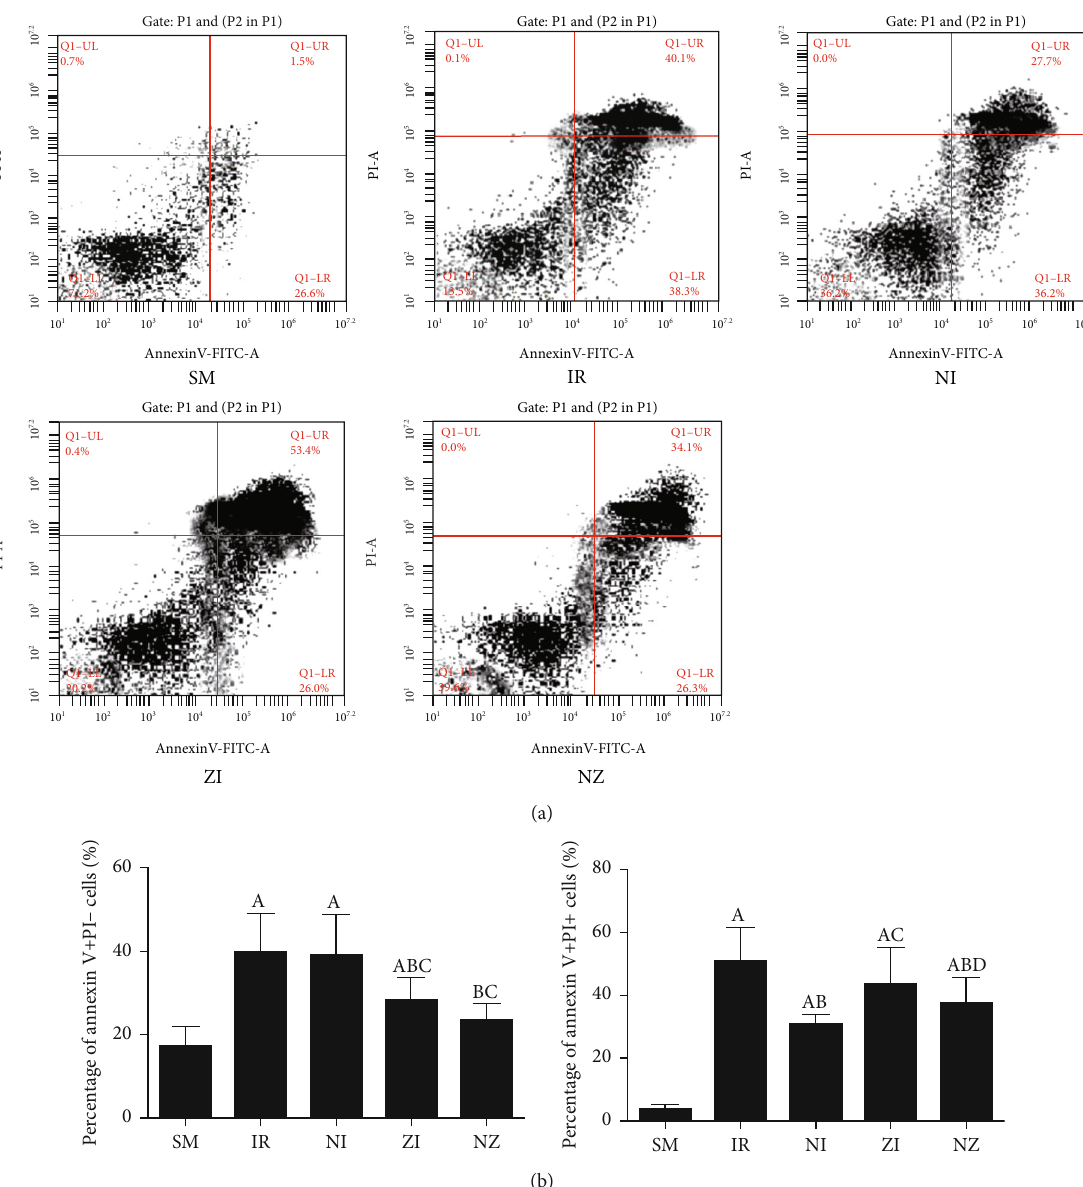
Figure 4: Flow cytometry analysis in lung tissue single-cell suspension. The rats were randomly divided into fi ve groups. Brie fl y, the rats in the SM group received sham operation, while the left lung hilum was subjected to 1h of ischemia followed by reperfusion up to 3h in the IR group. Intraperitoneal Nec-1 (1 mg/kg) and z-VAD-fmk (3 mg/kg) were administrated before lung ischemia in NI and ZI groups, respectively, and combined administration of Nec-1 and z-VAD-fmk was given in the NZ group. After 3 h of reperfusion, single-cell suspension of the lung tissue was prepared, and cell death was assessed using fl ow cytometry. Figures 4(a) and 4(b) are representative photomicrographs of di ff erent groups. Data were presented as mean ± SD , n = 8 in each group. a P < 0 : 05 compared with the SM group, b P < 0 : 05 compared with the IR group, c P < 0 : 05 compared with the NI group, d P < 0 : 05 compared with the ZI